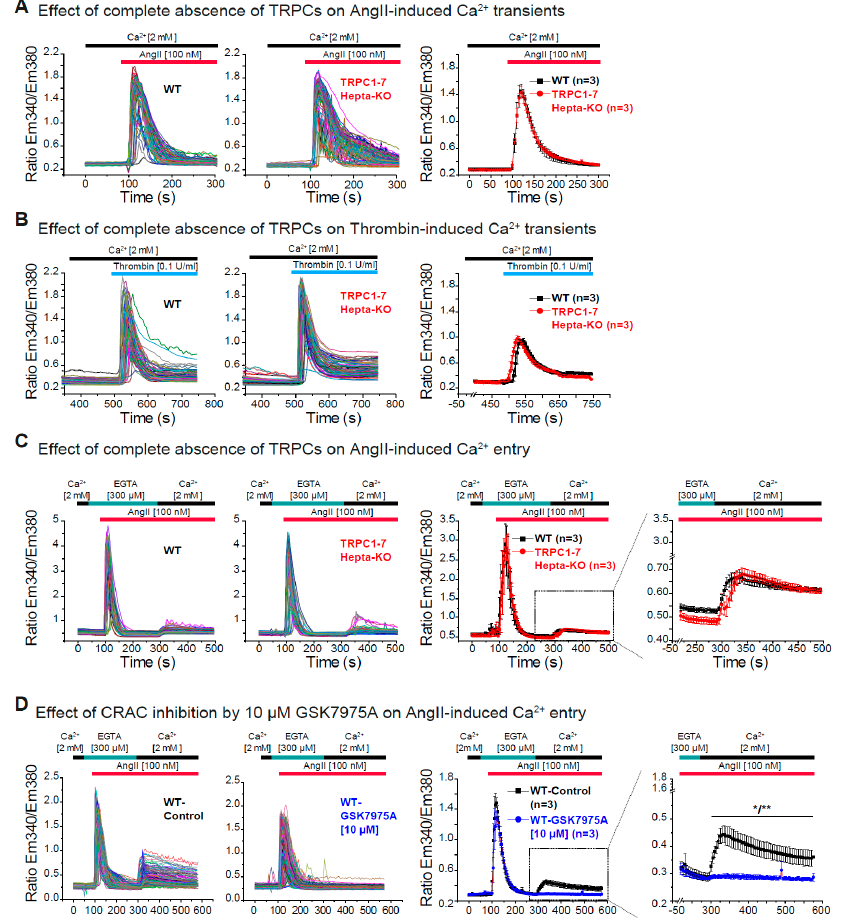
Figure 4. AngII-induced Ca 2+ release and Ca 2+ entry in cardiac fibroblasts in the absence of all seven TRPC proteins. ( A ) AngII- and ( B ) thrombin-induced Ca 2+ transients in primary CFs from WT (black) and TRPC-hepta ( Trpc1/2/3/4/5/6/7 –/– ) KO (red) mice. Ca 2+ transients were measured in the presence of 2 mM extracellular Ca 2+ . Left panels: Original traces and right panels: Mean values of three independent preparations (hearts). ( C ) AngII-induced Ca 2+ release and Ca 2+ entry in primary CFs from WT (black) and TRPC-hepta KO (red) mice. Ca 2+ release was measured in the absence of extracellular Ca 2+ (300 µM EGTA) and Ca 2+ entry was monitored in the in the presence of 2 mM extracellular Ca 2+ . Left panels: Original traces and right panels: Mean values of three independent preparations. ( D ) The effect of the CRAC blocker (10 µM) GSK7975A on the AngII-induced Ca 2+ release was analyzed in CFs from WT mice like in ( C ). Left panels: Original traces and right panels: Mean values of three independent preparations. n = number of independent preparations (hearts). All cells were analyzed 5 days after isolation and were cultured at high density. * p < 0.05 and ** p < 0.01 according to the unpaired Student’s t -test.